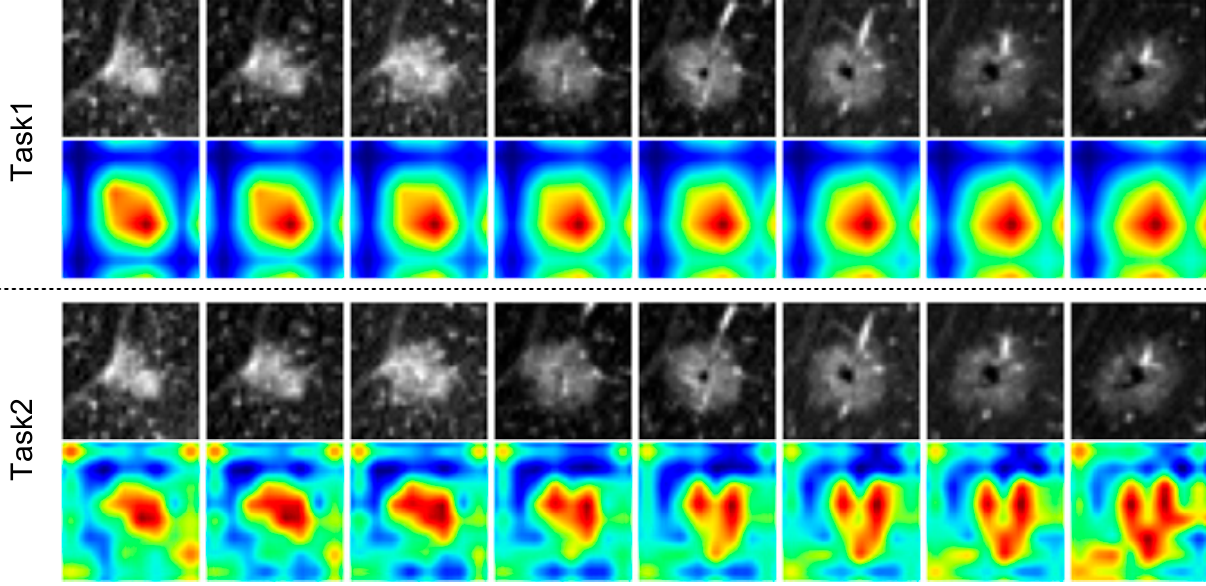
Figure A4. The heat maps of the deep image features for the proposed DNN model.